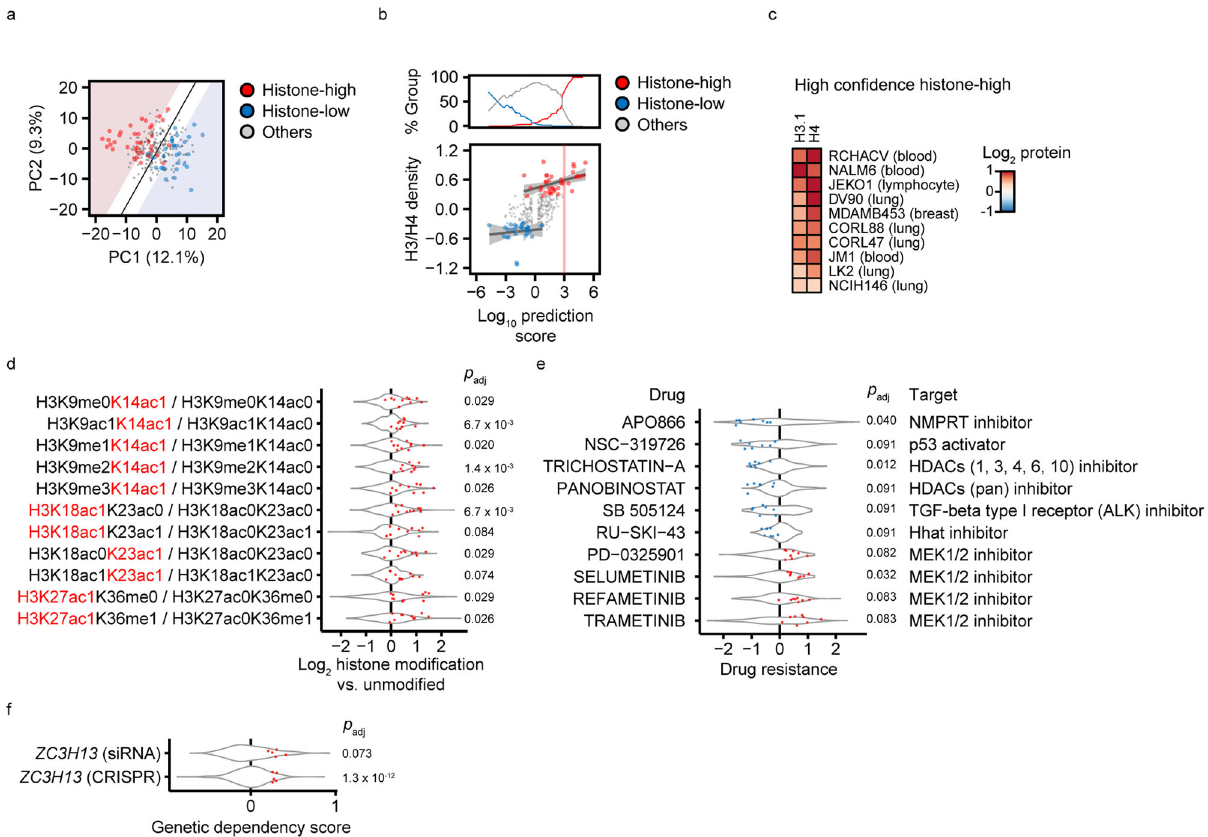
Fig. 5 Characterization of the histone-high state by comparative OMICs. a Cell line classi fi cation by histone density. PCA was applied to the expression data of signi fi cant proteins from Fig. 4a. The fi rst two principal components are plotted and each dot is one cell line. A logistic model was trained for the classi fi cation of histone-high (red, N = 37) vs. -low (blue, N = 31) cell lines. The red and blue areas mark a 95% classi fi cation con fi dence for histone-high and -low cell lines, respectively. Cell lines with normal histone content are shown in grey ( N = 209). b Contribution of histone-high ( N = 37), -low ( N = 31) and other ( N = 209) cell lines at a given prediction score from a , and histone density vs. the cell line classi fi cation con fi dence from a , where each dot is one cell line. Quantile regressions were separately performed for histone-high and -low cells. The log 10 prediction score re fl ects the likelyhood that a cell line is correctly classi fi ed as histone-high (positive range) or -low (negative range). Note that a strong prediction score for the histone-high state (>3), indicated by the red separator bar, is speci fi c for cell lines with particularly high histone dosage and separates them from histone-low and other cells. c Summary of high con fi dence histone-high cells ( N = 10) from ( b ) with representation of H3.1 and H4 levels as heatmap. d – f Characteristics of high histone density in CCLE datasets. Datasets from global chromatin pro fi ling ( d ), drug sensitivity ( e ) and gene dependency ( f ) were analyzed for signi fi cant differences between high con fi dence histone-high cell lines ( c , N = 10) vs. cell lines with normal or low histone density ( N = 240). All data were lineage-centered. The distribution of values in cell lines with normal or low histone density is indicated by violin plots. The distribution of values in high con fi dence histone-high cell lines is overlaid as blue dots (signi fi cant decrease) or red dots (signi fi cant increase). Signi fi cance between the two groups was analyzed with two- tailed, unpaired Student ’ s t -test with Benjamini-Hochberg correction ( p adj < 0.1, fold-change >1.2). All signi fi cant histone modi fi cations, drugs and gene dependencies are